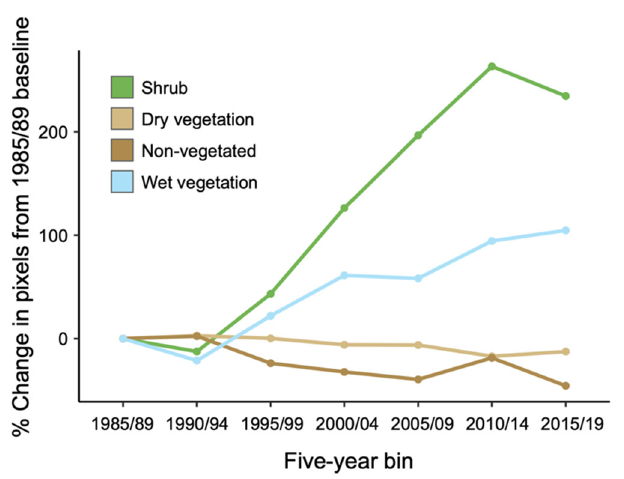
Figure 3. Percent change in the abundance of pixels in each land cover class relative to 1985/89 values.